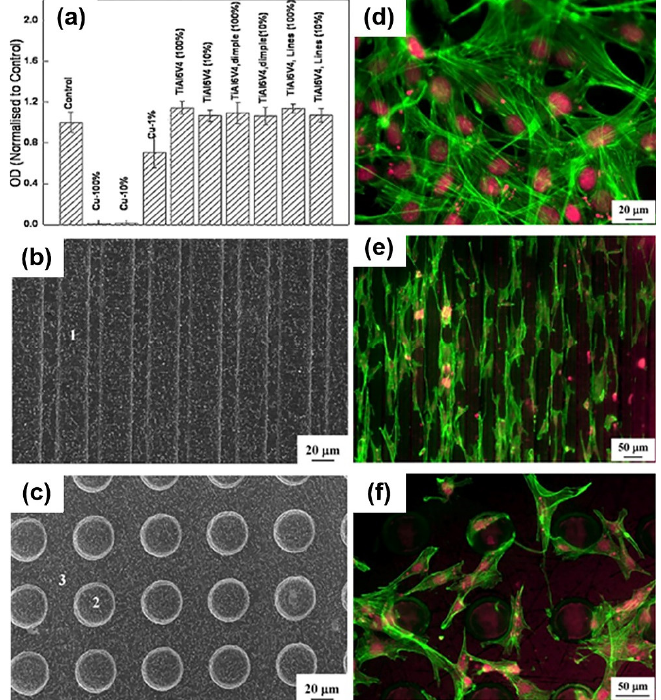
Figure 3. ( a ) XTT (Dimethoxazole yellow) results of cell viability of MC3T3-E1 fibroblast cells after 24 h in contact with the extracts in the as-received and laser textured surface; ( b , c ) SEM of the surface